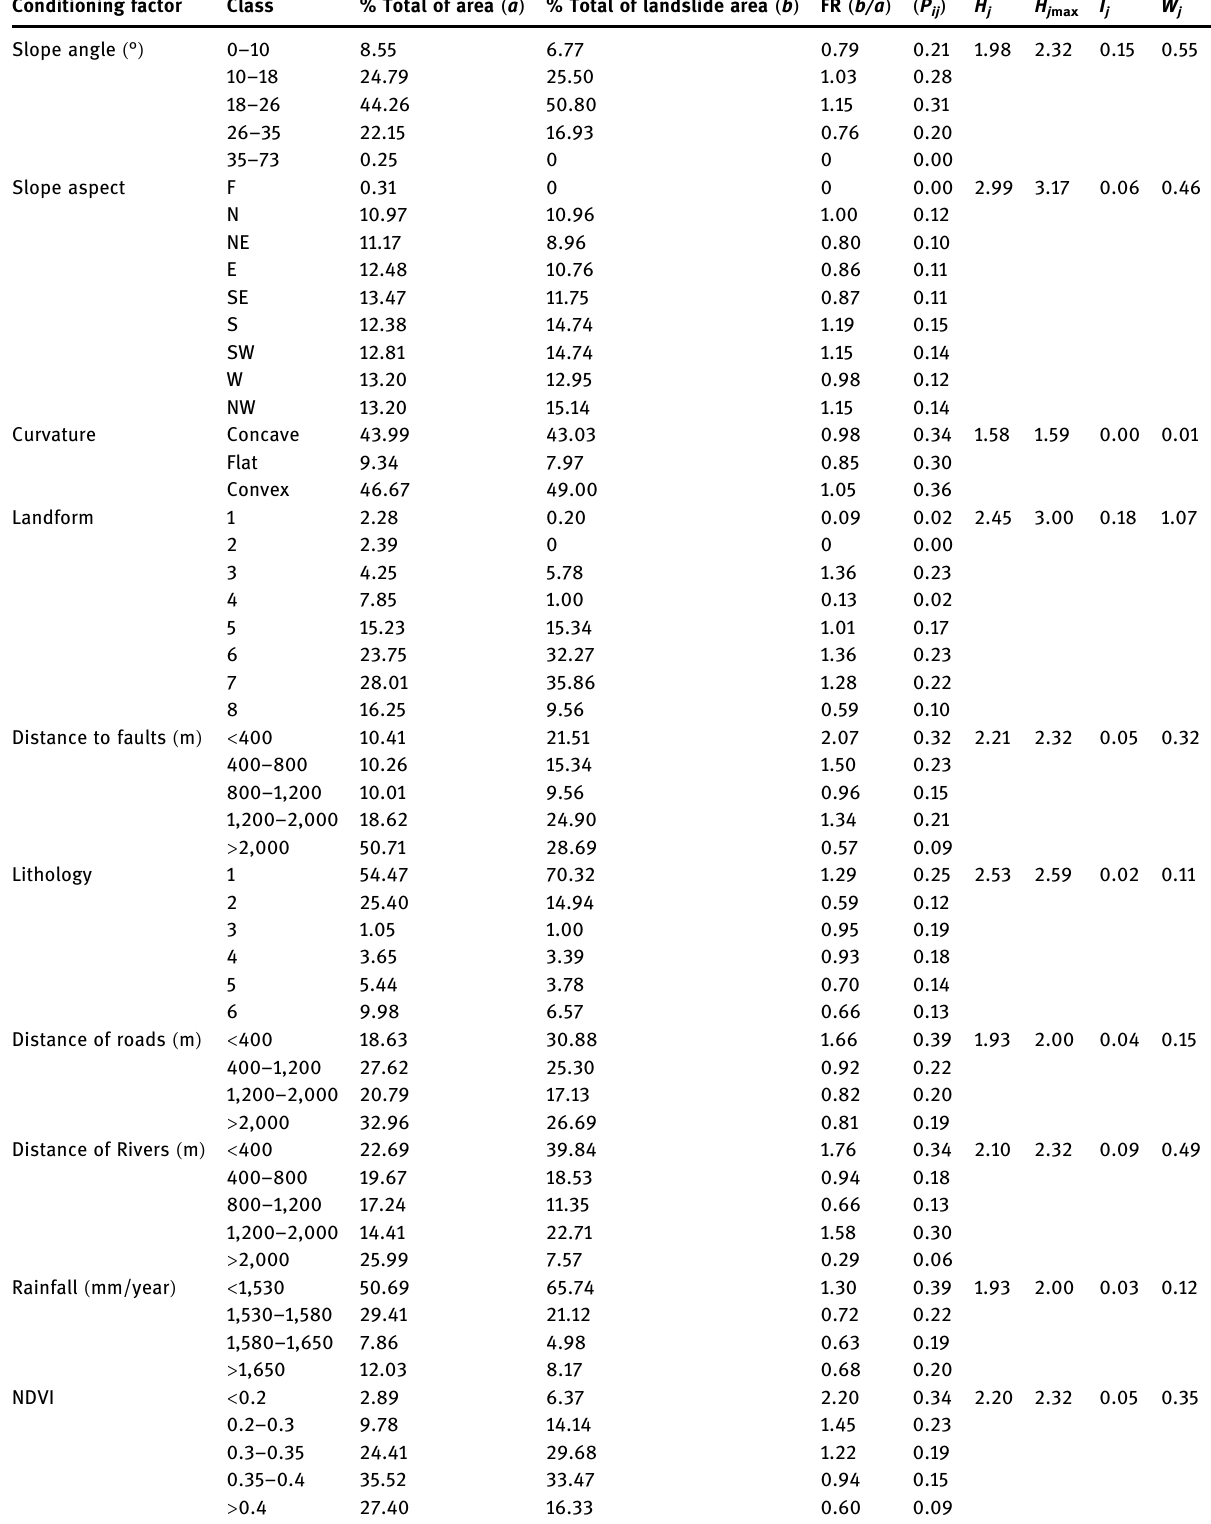
Table 2: Spatial relationship between conditioning factor and landslide by FR and IOE models Conditioning factor